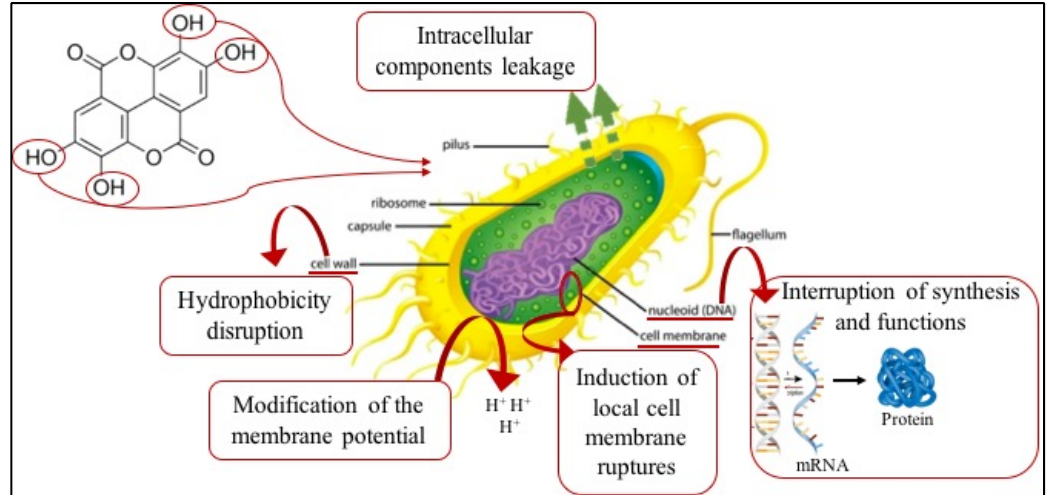
Figure 4. Mechanism of action of polyphenols on a microbial cell.